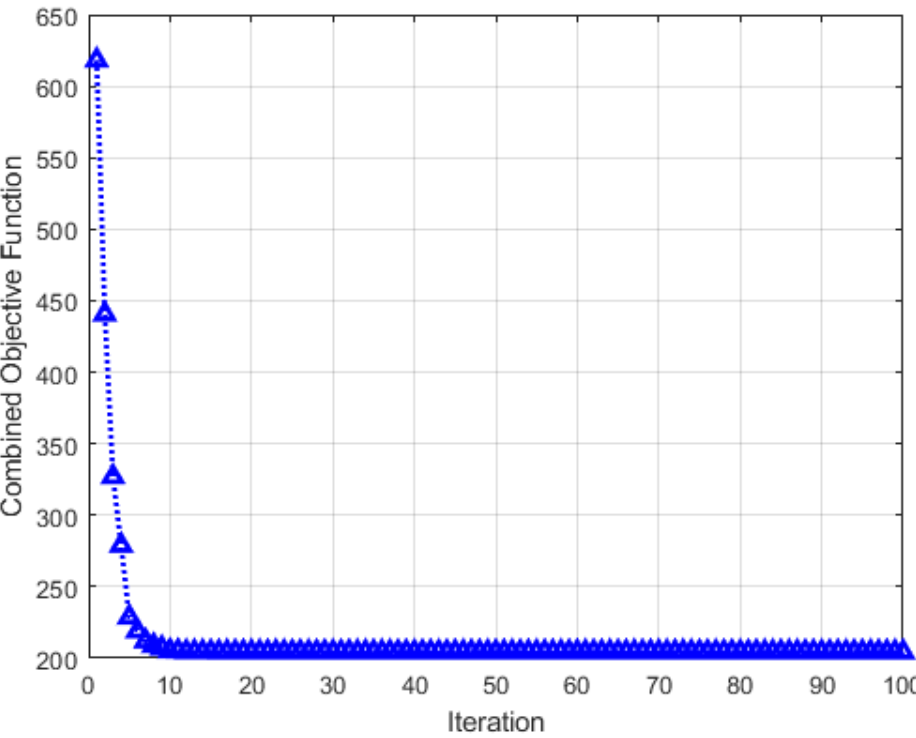
Figure 17. Attainment of combined objective function value during execution.